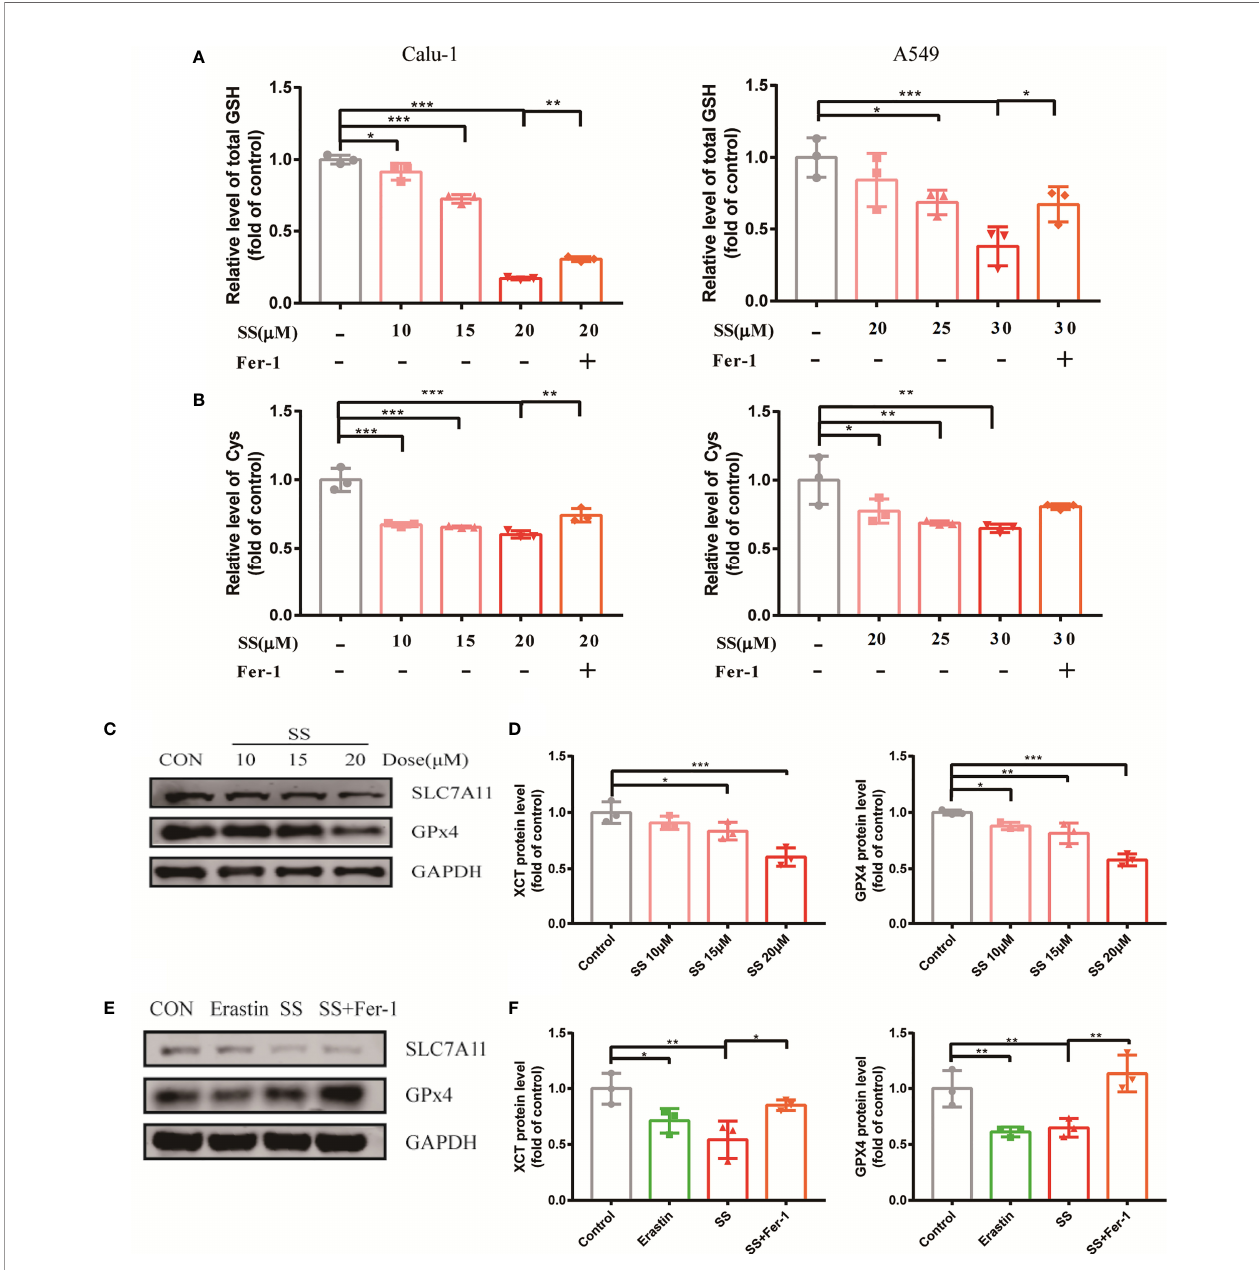
FIGURE 4 | SS attenuated the oxidation resistance of LUAD cells. (A, B) GSH or Cys was detected in Calu-1 or A549 cells, which were respectively treated with 10, 15, 20 m M or 20, 25, 30 m M SS for 6 h, and pretreated with or without Fer-1 (1 m M), the data statistic was shown in a histogram (*P < 0.05, **P < 0.01, ***P < 0.001). (C) Western blot analysis was used to detect the expressions of SLC7A11 and GPX4 in Calu-1 cells, which were treated with 10, 15, 20 m M SS for 6 h. (D) Quantitative analysis of gray value of the SLC7A11 and GPX4 blots. (E) Western blotting analysis was used to detect the expressions of SLC7A11 and GPX4 in Calu-1 cells, which were treated with 20 m M SS or 4 m M erastin, with or without Fer-1 (1 m M) for 6 h. (F) Quantitative analysis of gray value of the SLC7A11 and GPX4